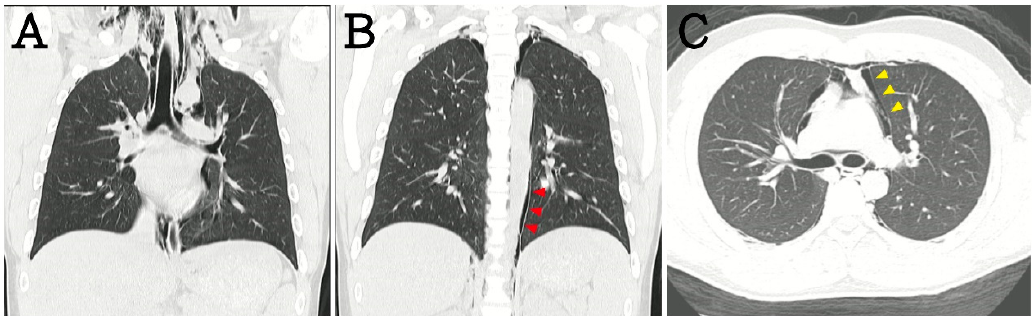
Figure 2. In computed tomography (CT) scans, these results were also noted, including ( A ) Figure2. Incomputedtomography(CT)scans, theseresultswerealsonoted, including( A )subcutaneous subcutaneous emphysema, ( B ) periaortic gas, and ( C ) pericardiac gas. emphysema, ( B ) periaortic gas, and ( C ) pericardiac